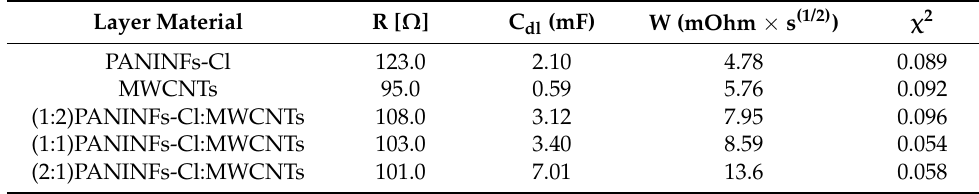
Table 2. Electrical parameters for the tested electrodes determined by